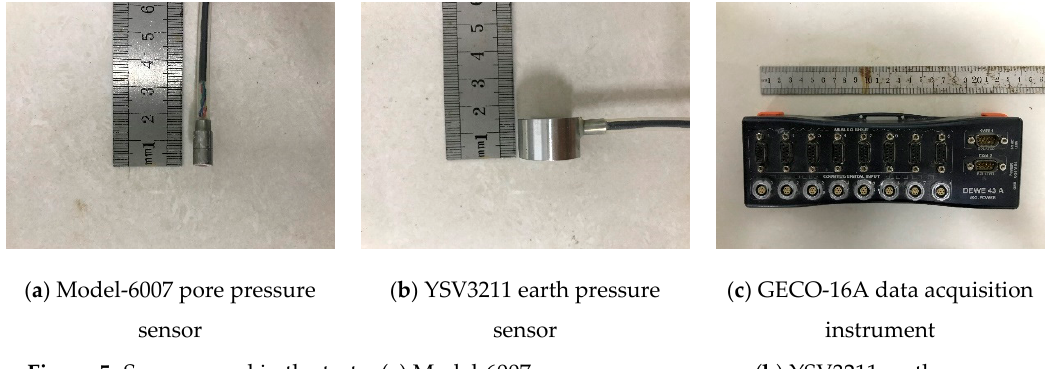
Figure 5. Sensors used in the tests. ( a ) Model-6007 pore pressure sensor; ( b ) YSV3211 earth pressure sensor; ( c ) GECO-16A data acquisition instrument.